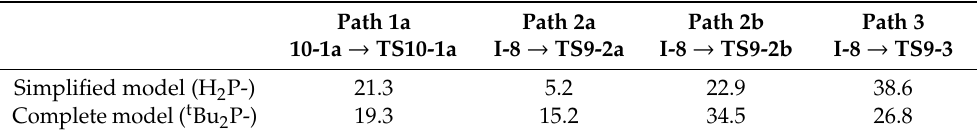
Table 1. Summary of the reaction energy barrier of the rate-determining steps of Path 1a, Path 2a, Path 2b and Path 3, based on simplified and complete model (kcal /